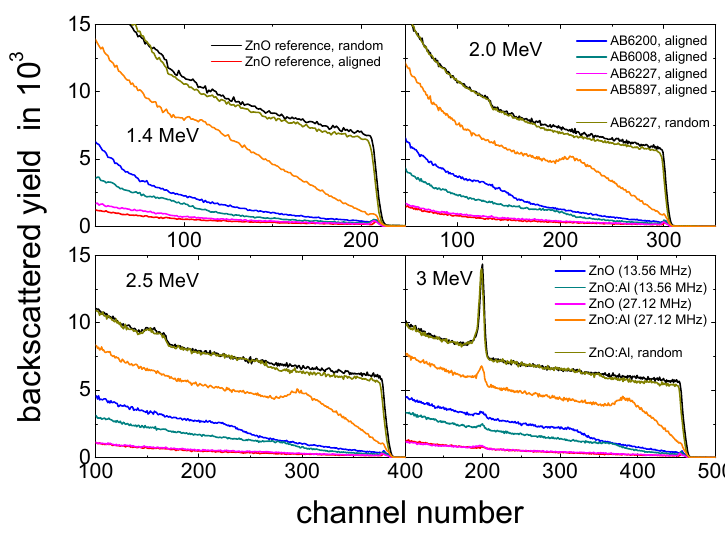
Figure 3. Energy spectra of He ions of different ion energies backscattered in homoepitaxial ZnO and ZnO:Al layers fabricated under various sputtering conditions. Spectra in aligned and random directions for a ZnO single crystal are shown for comparison. Beam energies and names of the samples are indicated in the figure.